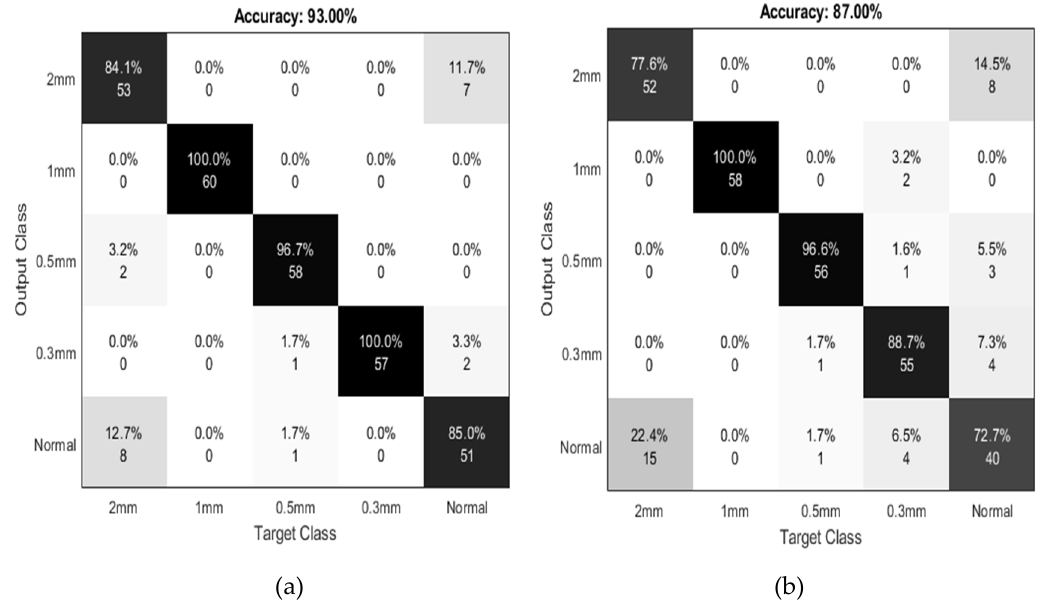
Figure 6. Confusion matrices of classification result for ( a ) the proposed method for impulse detection with ECFAR and ( b ) wavelet threshold-based impulse